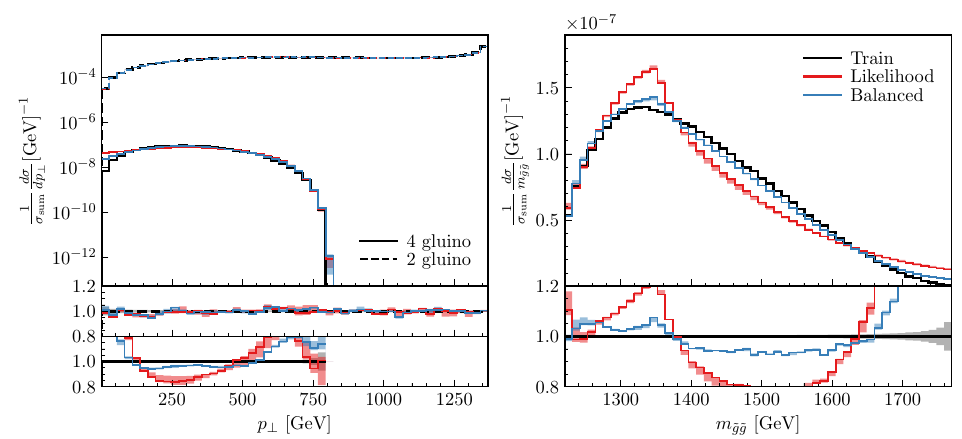
Figure 8: The transverse-momentum spectrum (left) of four-gluino events (solid) and two-gluino events (dashed), as well as the digluino invariant mass spectrum (right) of four-gluino events. The MC truth (black) is compared with the model illustrated in figure 7 trained by maximizing eq. (15) (red) and eq. (16) with the elements of the weight vector r set to 1 / 2 (blue). The error bands correspond with variations I ↓ between three independent